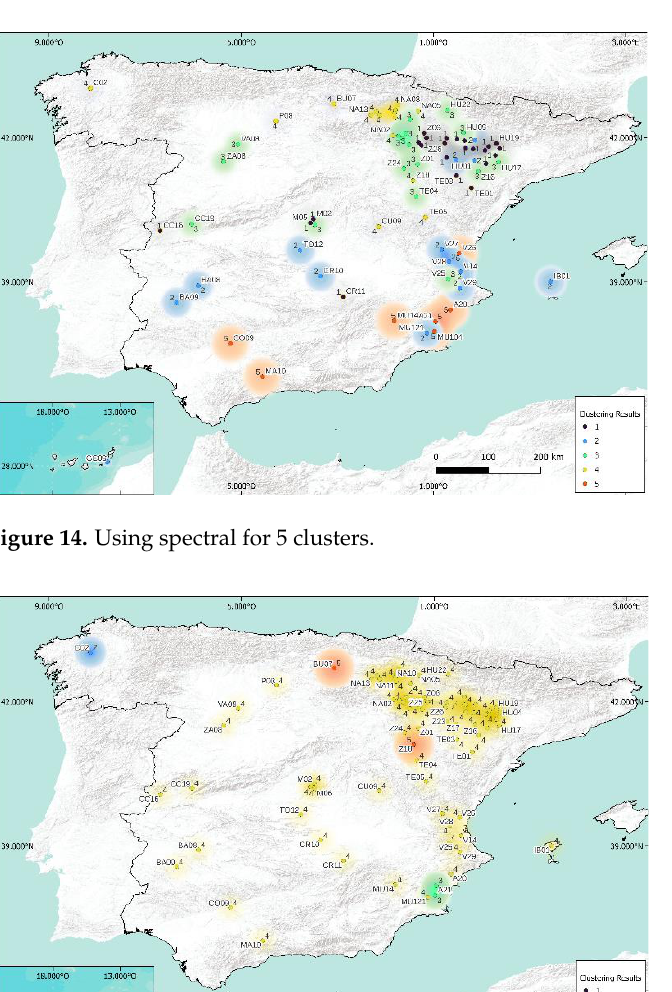
Figure 15. Using hierarchical for 5 clusters.